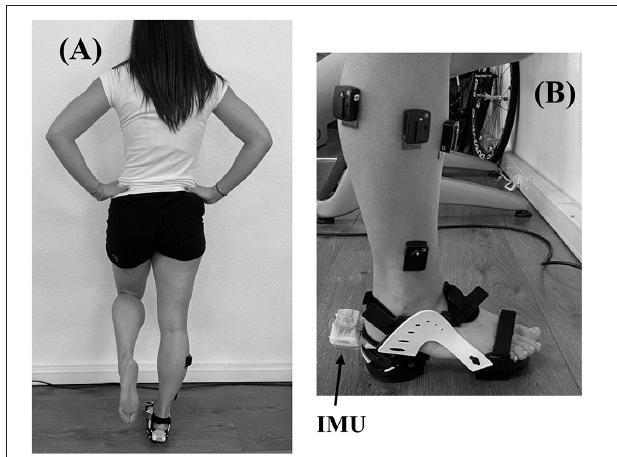
FIGURE 1 | (A) Postural test execution; (B) Destabilization